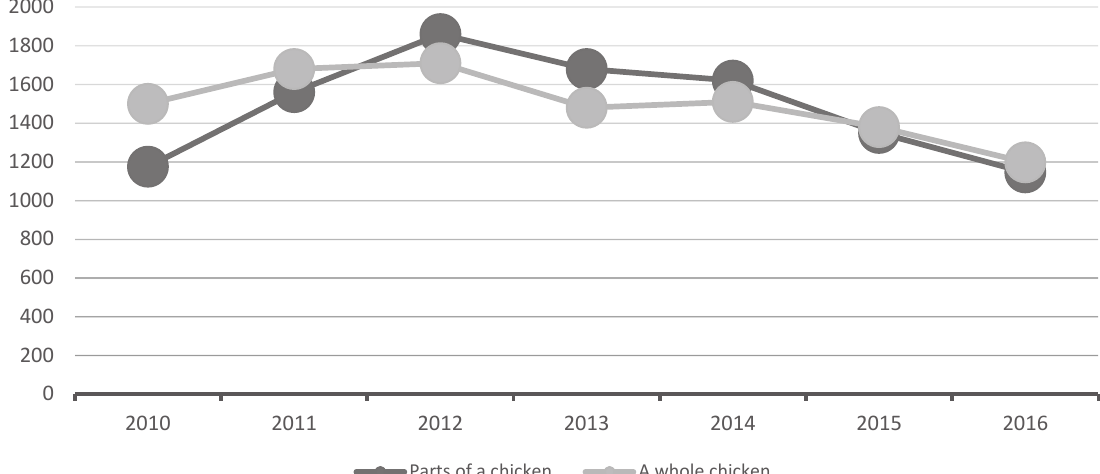
Figure 6. Dynamics of export prices headings in US$ / ton in